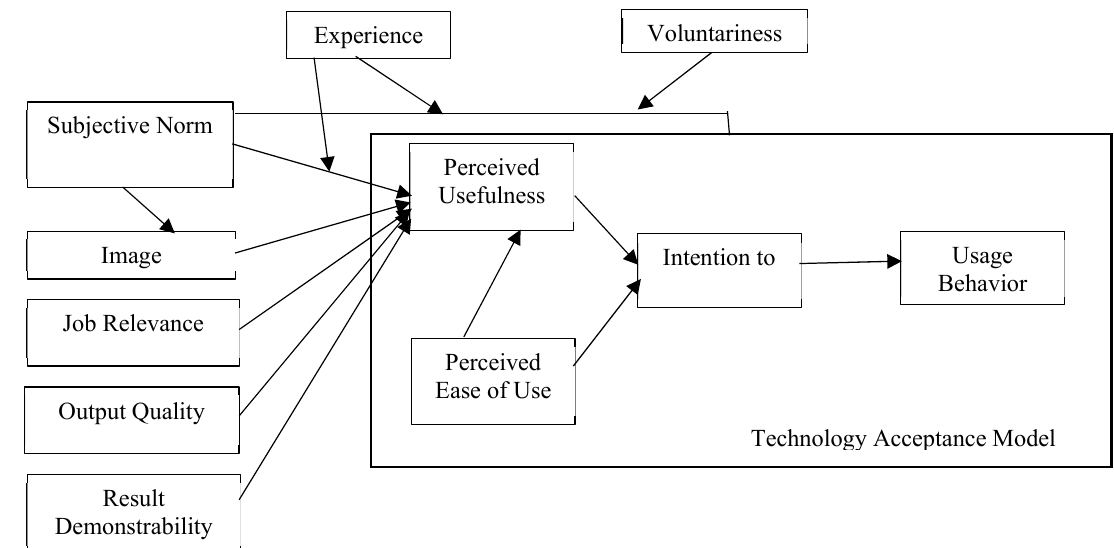
Fig. 3 Extended Model of TAM (TAM2)